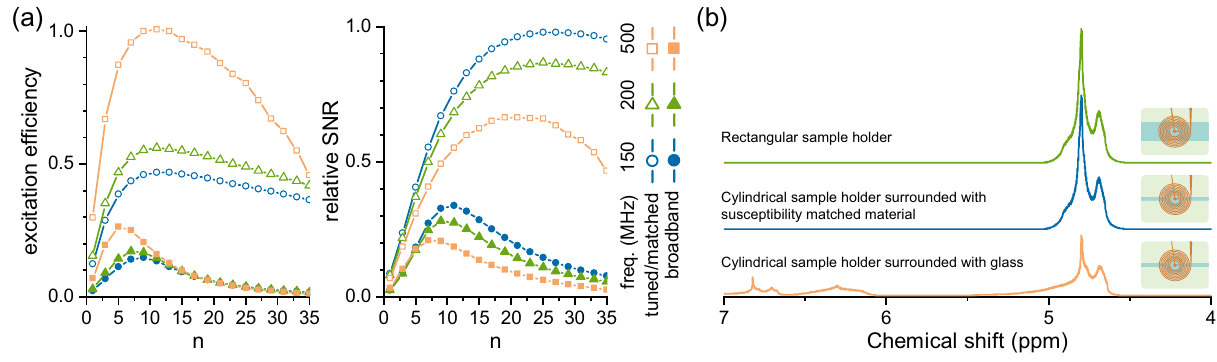
Figure 2. The results of both RF and B 0 simulations (presented in Fig. S1) were post-processed to calculate the figures of merit and NMR spectra of the spiral coils. The coil geometry is defined by an inner diameter of 250 µ m , a track width of 20 µ m , a track spacing of 20 µ m , and a track thickness of 20 µ m . ( a ) The figures of merit are calculated for both tuned/matched and broadband coils, and for a sample of 500 µ m in diameter, 500 µ m in height, a 100 µ m gap between the sample and the coil, and as a function of the number of turns. The plots are normalised to their maximum value. ( b ) NMR spectra of the optimised broadband coil (n=8) for three different sample holders, at 500 MHz corresponding to the 1 H Larmor frequency at 11.74 T. The distortions in the peak shape correspond to the susceptibility mismatch between the sample, coil, air, and the sample holder. The volume magnetic susceptibility for different materials are assigned according to values 0 , χ glass 9.035 10 − 6 , 11.059 10 − 6 , χ water reported elsewhere 41,42 . These values are as follows: χ air = = − × = − × χ gold 9.63 10 − 6 34 10 − 6 , χ copper = − × = − ×